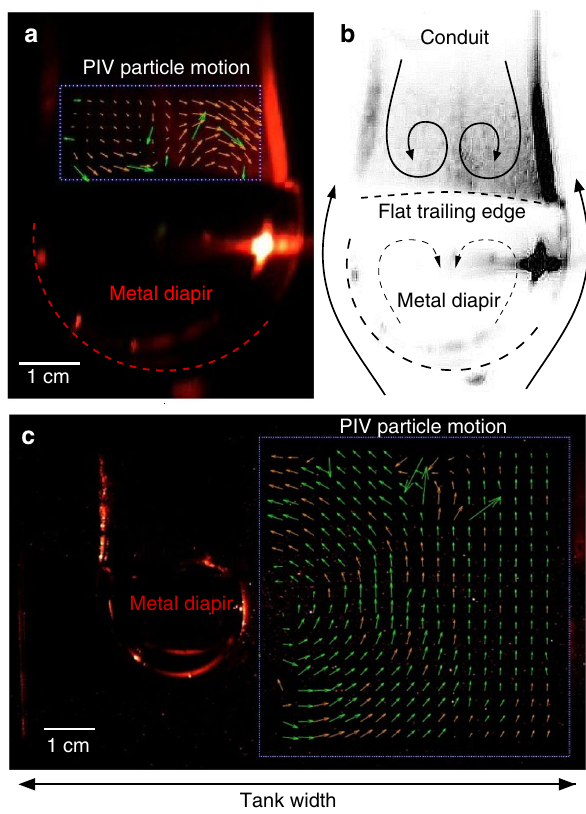
Fig. 3 Flow visualization. a Particle image velocimetry (PIV) image capturing stream lines of circulation within a conduit. Image is dark due to photography taken in the absence of light illuminating the He-Ne laser sheet passing through the fl uid experiment. Vectors indicate particle motion (silver-coated glass microspheres) suspended in μ 1 during diapir descent and are tracked within the conduit only. Arrow length scales with fl uid velocity. Green arrows indicate resolved particle motion between two frames taken at nine frames per second. Orange arrows are the interpolated vector fi eld in time and space. (Note shorter vectors on left side of the conduit are caused by lower lighting not captured by the laser sheet and does not necessarily indicate slower fl uid motion.) Dashed line is the inferred outline of the metal diapir. b Inverted negative image in gray scale of diapir and conduit descent as in a . Solid black streamlines indicate fl ow lines inside and outside the conduit which are resolved by the PIV vector fi eld shown in a , c , respectively. Dashed streamlines and metal diapir outline are inferred. The PIV vectorization (green and orange arrows) indicates that drag along the inside of the conduit walls and at its base causes circulation at the base of the conduit which depresses the top of the descending metal diapir and fl attens the top of the diapir surface shaping a liquid metal lower hemisphere during descent. c PIV image of a descending metal diapir (with particles seeded in S 2 fl uid only). PIV particle motion tracking is limited to right side of diapir only (taking advantage of symmetry). Return fl ow (green and orange particle motion vectors) surrounding the diapir extends to a lateral distance approximately equal to the diapir radius, beyond which edge effects are negligible. The fl ow fi eld visualized on the right side of the diapir is used to infer the solid fl ow lines outside the diapir in controlled by S1 buoyancy. The reduction in conduit radius is slower than during regime 1. In regime 3 thin conduits collapse slowly (displaying a shallow slope) after most of the S1 fl uid has exited and includes slow diffusion with the surrounding S2 material. Thin conduits (regime 3) are observed to persist, how- ever, for long times.